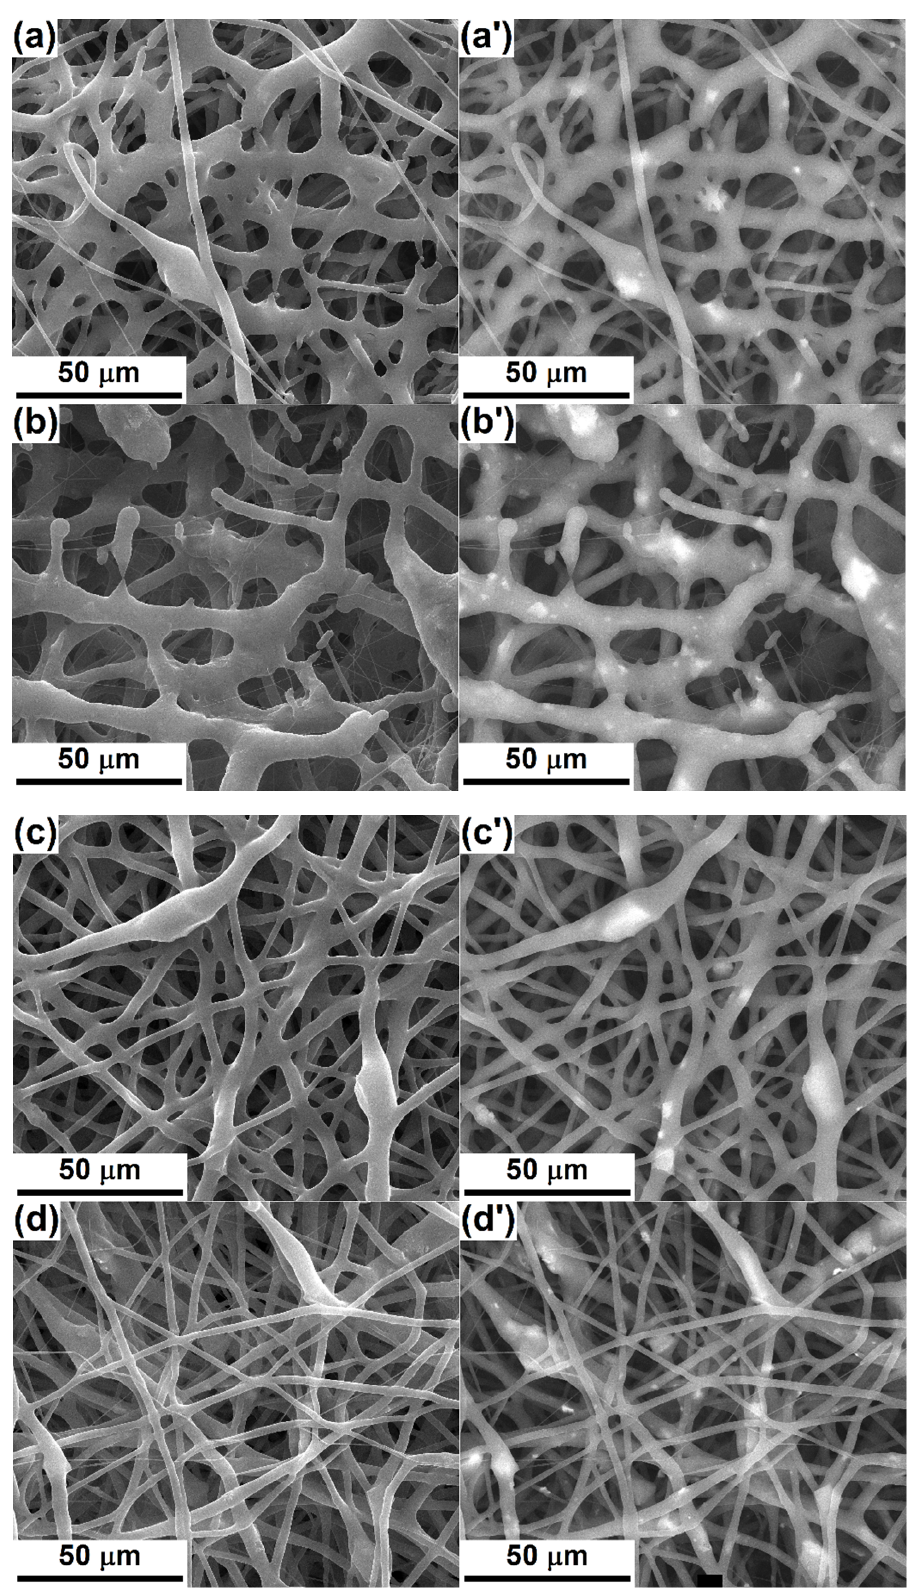
Figure 3. SEM images, based on secondary electrons (left) or backscattered electrons (right), of: ( a , a' ) PCL-Mg-1, ( b , b' ) PCL-Mg-5, ( c , c' ) PCL-Sr-1 and ( d , d' ) PCL-Sr-5 scaffolds.